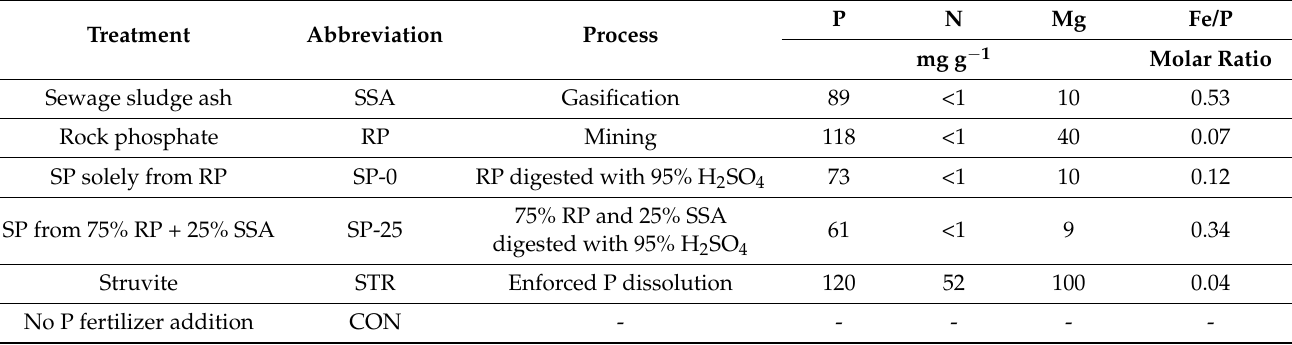
Table 1. Fertilizer treatments and their abbreviations, production processes, and mean concentrations of phosphorus (P), nitrogen (N), magnesium (Mg), and iron to P